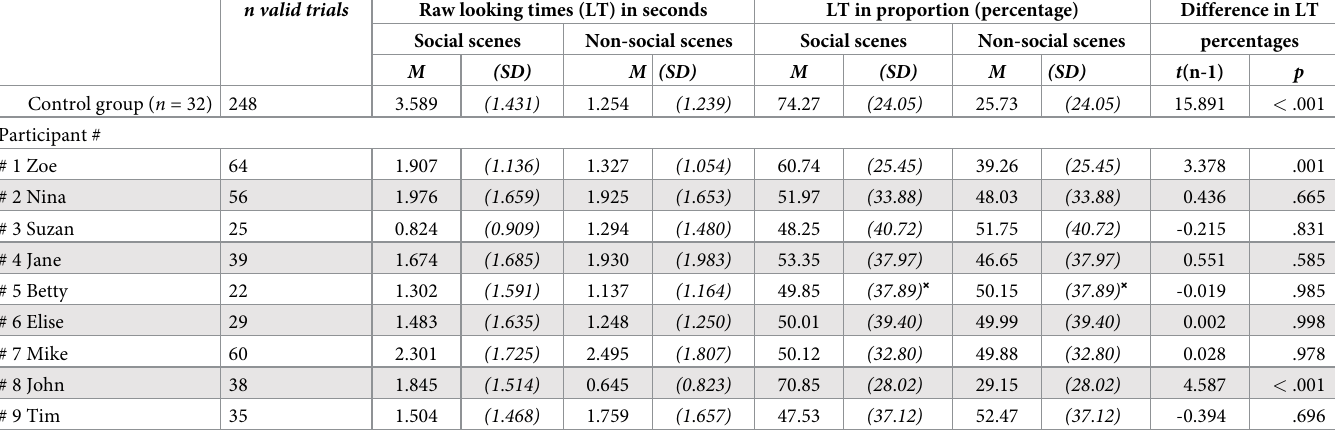
respectively) than at the mouth (36.09, 19.7, 38.66, and 29.46%, respectively). Furthermore, among the five participants where the difference was not significant, none showed the opposite pattern: all PIMD individuals tended to look longer at the eyes than the at the mouth area. Results are detailed in Table 7. Happy vs. angry faces. The control group showed a significant difference in emotion dis- crimination, with a visual preference for angry faces over happy faces (56.77 vs. 43.23%, SD = 16.57), t (124) = 4.57, p < .001. No significant difference was found in the LT percentages Table 6. Mean (and SD ) looking times (raw and percentage) at each of the two stimuli of the SO-Task (i.e., social vs. non social scenes), consisting of eight 5-second trials, of the control group and the nine PIMD participants. n valid